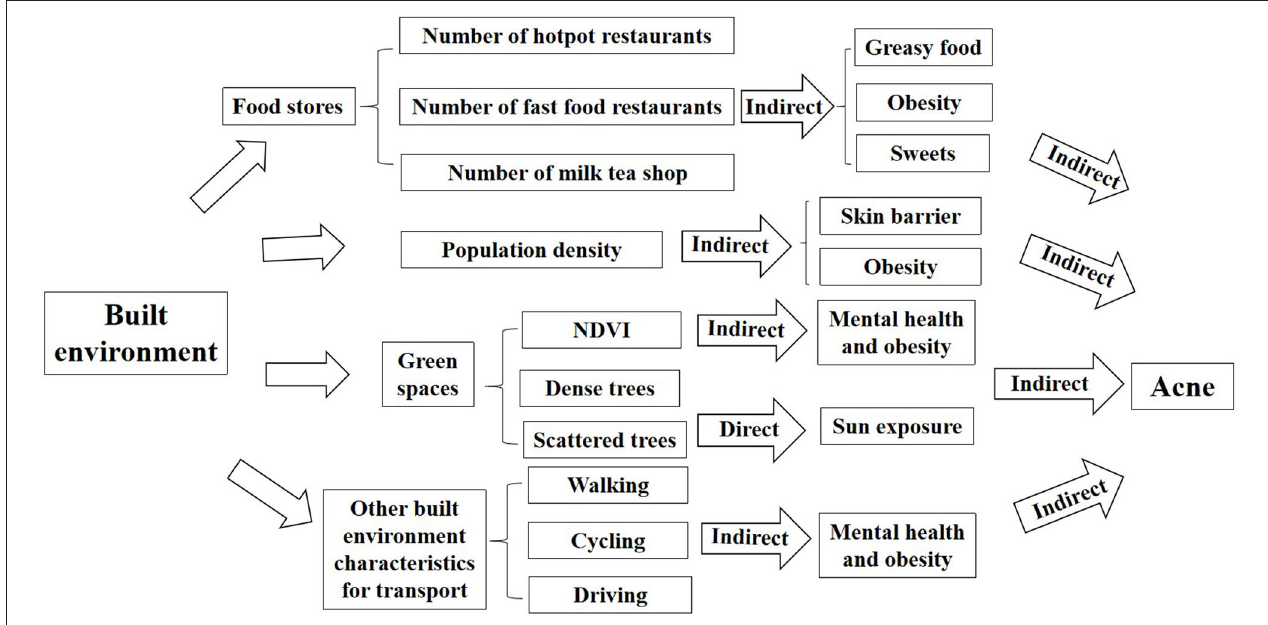
FIGURE 6 | The framework of impacts of built environment on acne (indirect: there is an indirect effect; direct: there is a direct